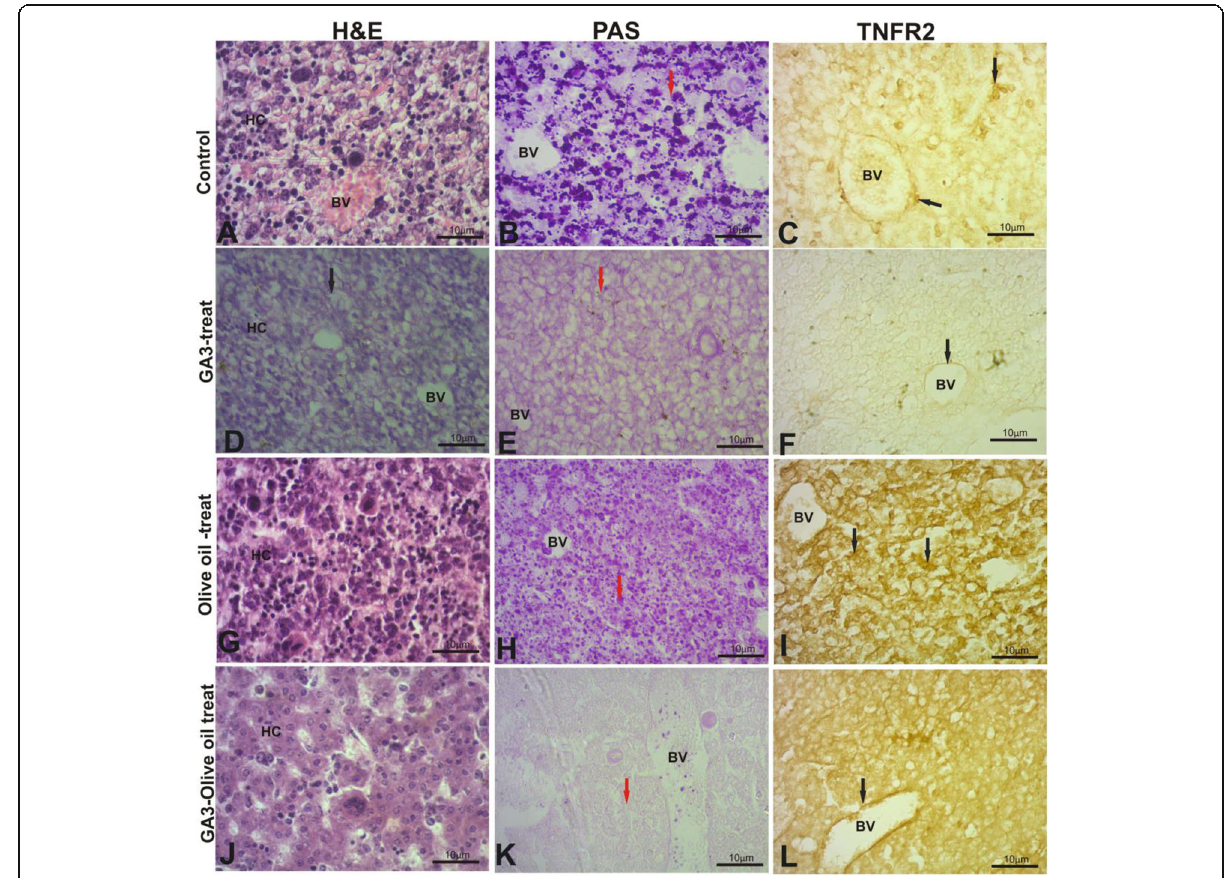
Fig. 5 Photomicrographs of H&E-, PAS-, and TNFR2-stained sections of developing liver at E18. The control liver showed normal structure of hepatic cord, positive carbohydrates (red arrow, b ), and TNFR2 expression was localized in blood vessel and in some hepatocytes (black arrow, c ). GA3-treated group exhibited loosely arranged hepatic cords with pale-staining and vacuolation (black arrow, d ), decrease the PAS reaction (red arrow, e ), and decrease TNFR2 expression (black arrow, f ). Olive oil-treated embryo did not exhibit any alteration in H&E and PAS ( g , arrow h ) but showed an increase of TNFR2 expression (black arrow, i ). GA3-olive oil-treated embryo showed improvement in the GA3 alterations ( j , arrow k , arrow l ). BV, blood vessel; HC, hepatic cords. Scale bar ( a – l ) = 10 μ